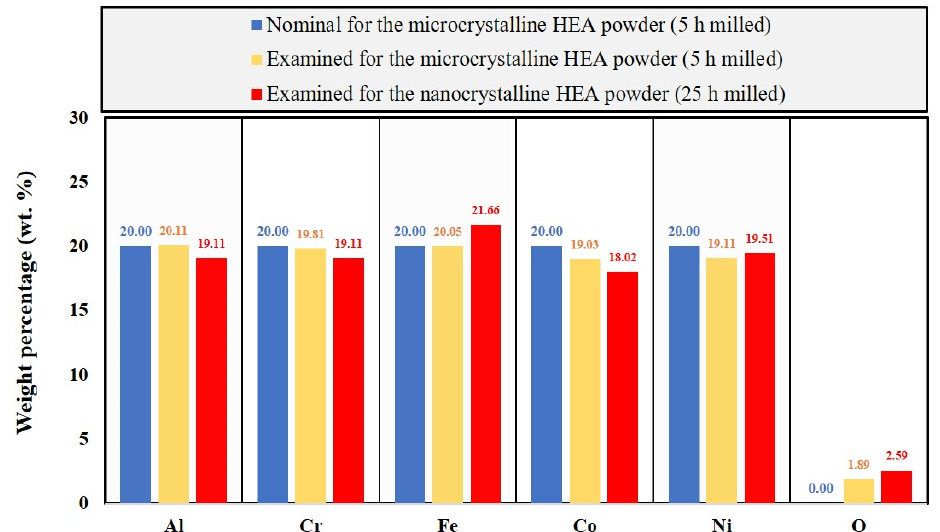
Figure 3. Atomic absorption spectroscopy (AAS) elemental data for the as-milled microcrystalline and nanocrystalline AlCrFeCoNi HEA powders obtained after 5 and 25 h of ball-milling process, respectively (All AAS wt.% were provided with the same error percentage of ±5% and accuracy of 10 − 2 ).